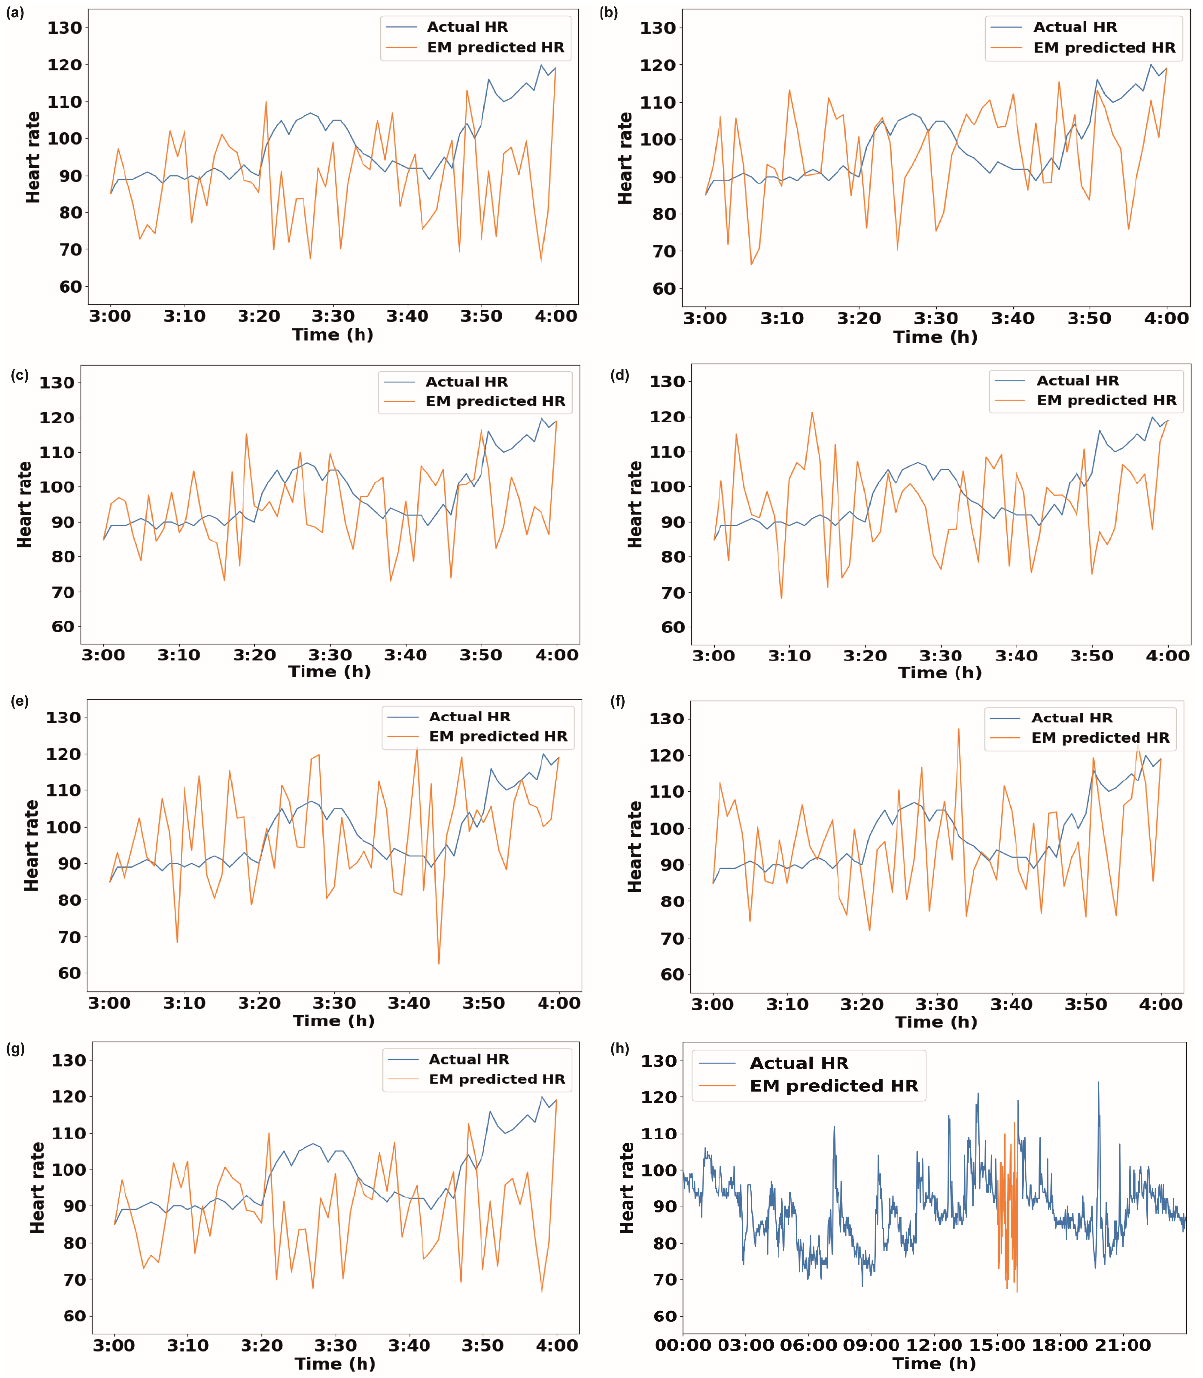
Figure 3. Actual heart rate data and imputed heart rate data using EM methods for 1 h of missing data from 3 pm to 4 pm. The bin sizes are ( a ) 1 h, ( b ) 2 h, ( c ) 3 h, ( d ) 4 h, ( e ) 5 h, ( f ) 6 h, and ( g ) entire data. ( h ) Heart rate data for entire day along with imputed values obtained from EM method using data with 1 h bin size when data were missing from 3 pm to 4 pm.